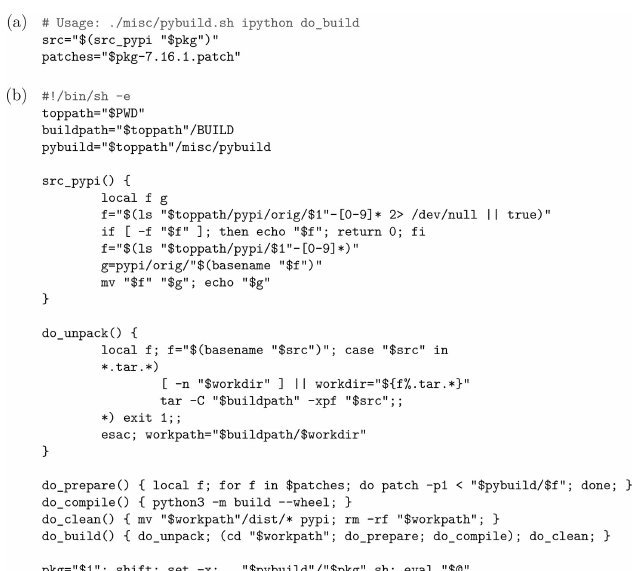
Figure 5 ( a ) ipython : sh , the definition file of the ipython package customized at HEPS; ( b ) a condensed pybuild : sh , expected to be executed from the root directory of the build